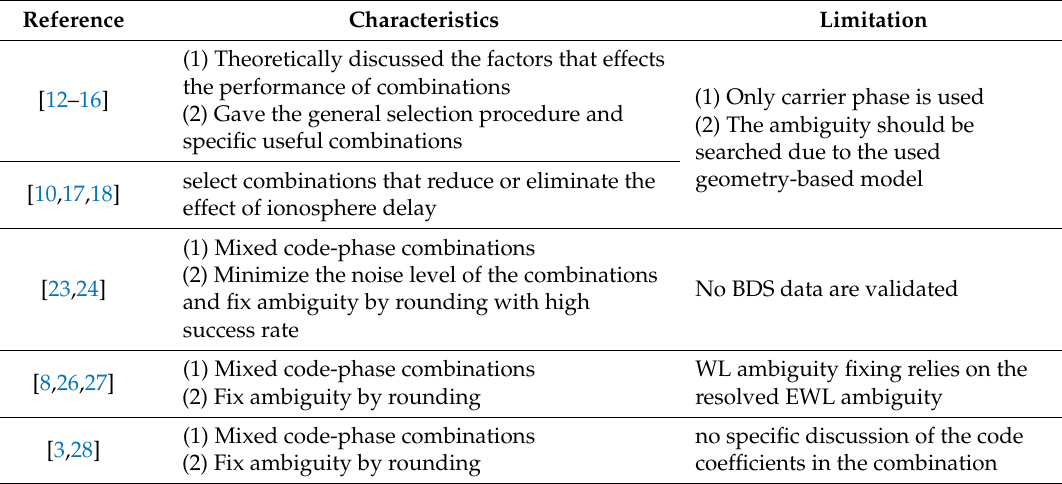
Table 1. Overview of several contributions to the optimal combinations for reliable